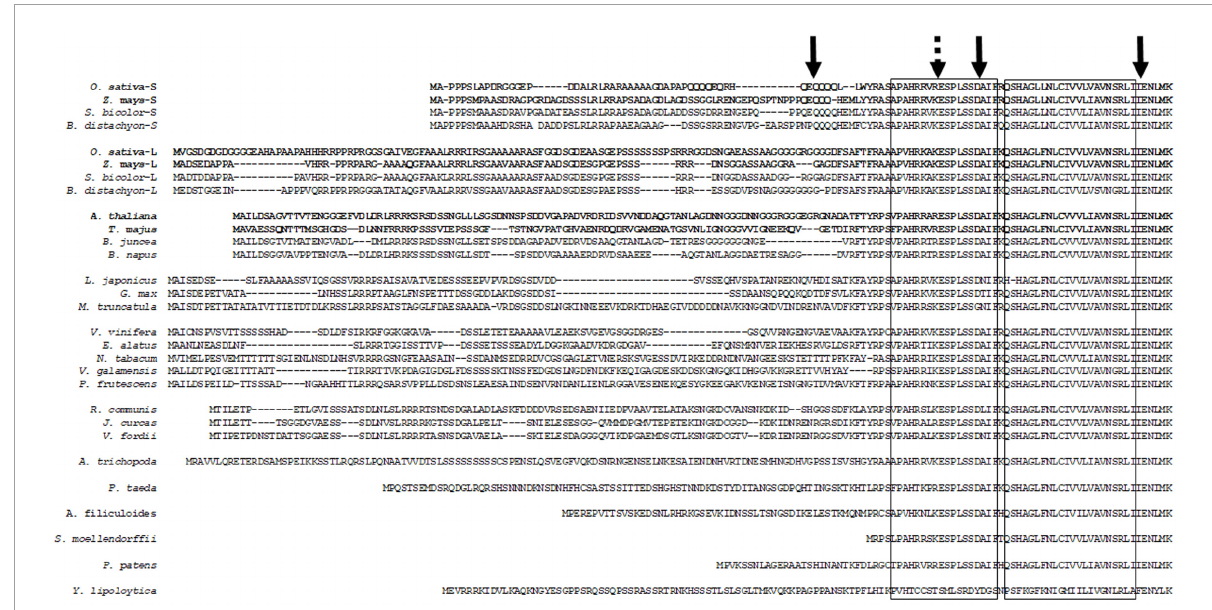
FIGURE1 Alignment of representative plant DGAT1 N-terminal cytoplasmic regions and predicted first transmembrane domain. A number of these sequences are putative. Left hand box indicates acyl-CoA binding domain (Nykiforuk et al., 2002), right hand box indicates predicted first transmembrane domain (McFie et al., 2010). Left hand solid arrow indicates N-terminal truncation site used in this study and 3 (cid:48) end of the Poaceae family DGAT1 GC compositional gradient. Dashed arrow indicates engineered Xho I restriction/ligation site used to generate chimeric DGAT1s. Center solid arrow indicates exon1-exon2 boundary, right hand solid arrow indicates exon2-exon3 boundary. Bold face species name and sequences indicate peptides used in this study. Accession numbers as follows: A. trichopoda (XM_006853832.3); A. thaliana , NP_179535; A. filiculoides (Azfi_s0008.g011645); B. distachyon (long), XP_003568769; B. distachyon (short), XP_003560655; B. juncea , AAY40785; B. napus , AAD45536; E. alatus , AAV31083; G. max , NP_001237289; J. curcas , NP_001292926 and XP_012076954; L. japonicas , AAW51456; M. truncatula , XP_003595231; N. tabacum , NP_001313014 and XP_016503808; O. sativa (long), XP_015639406; O. sativa (short), XP_015641041; P. frutescens , AAG23696; P. patens , XP_001770929; Pinus taeda (1c1| PgdbPtadea_13664 congenie.org); R. communis , NP_001310663